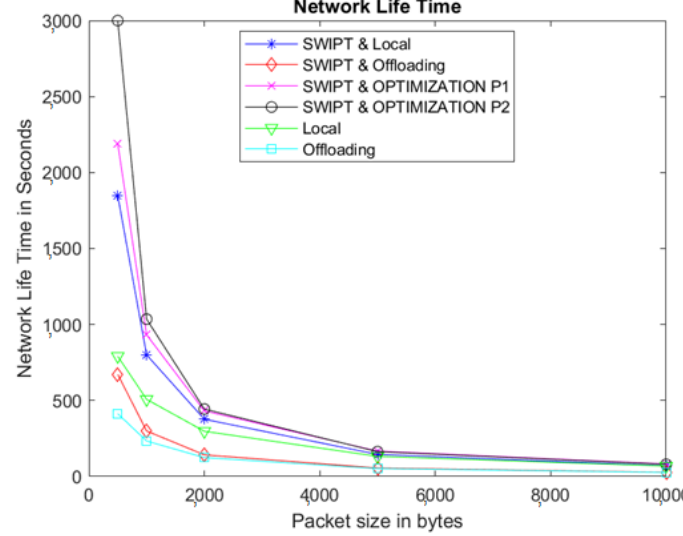
Figure 11. Network lifetime with variable packet size.